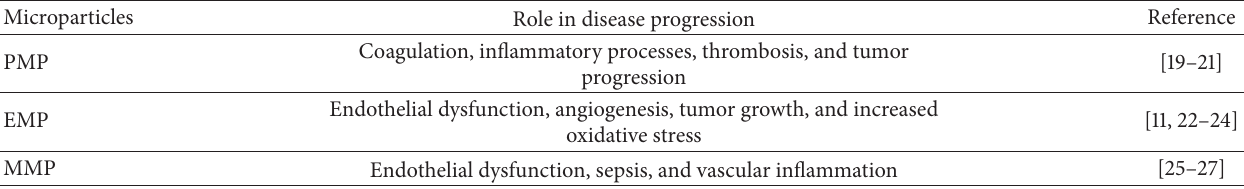
Table 1: The types of microparticles and their role in disease